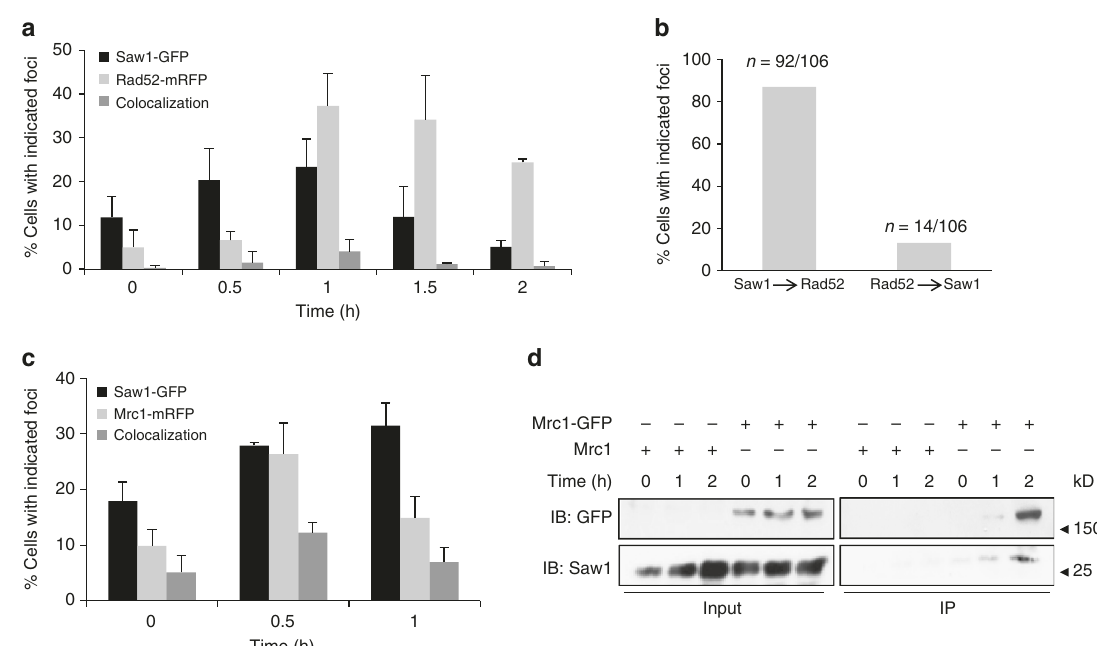
Fig. 3 Association of Saw1 at stalled replication fork upon HN 2 treatment. a Saw1-GFP and Rad52-mRFP foci formation in cells released from G1 arrest at indicated time points post HN 2 treatment. Over 1000 individual cells were analyzed for nuclear foci formation. Error bars represent standard error of the mean from three independent experiments. b Percentage of cells forming both Saw1-GFP and Rad52-mRFP foci with a distinct temporal fashion. c Formation and co-localization of Saw1-GFP and Mrc1-mRFP foci at indicated time points post HN 2 treatment. d Saw1 associated with chromatin pulled down by Mrc1-GFP in cells released from G1 and at indicated time post HN 2